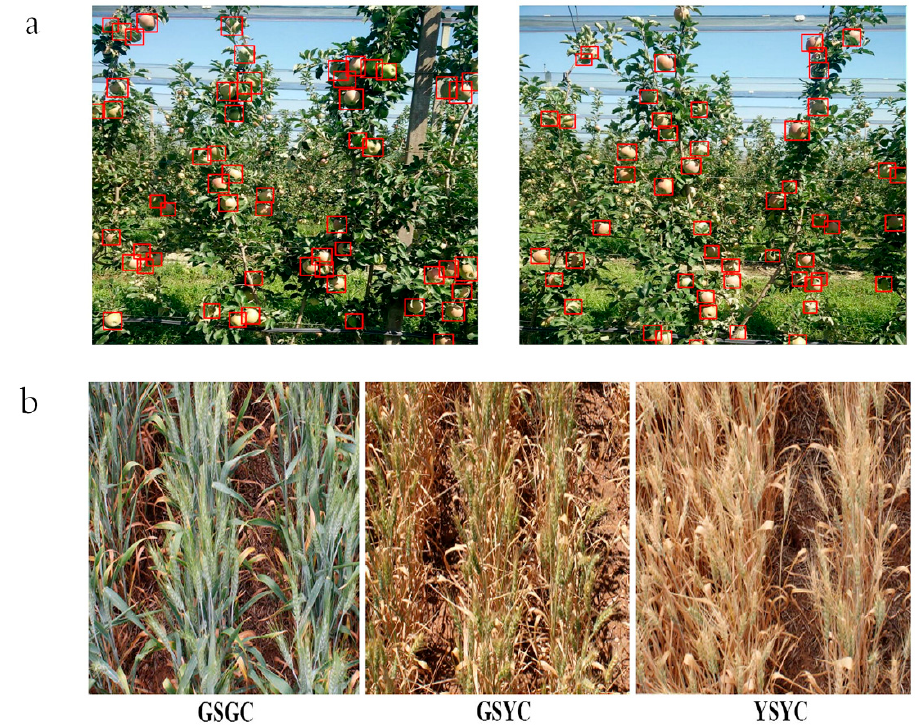
Figure 1. Dense scenes in agriculture. ( a ) Detecting fruits in an orchard. Source: [31] is licensed under https: // creativecommons.org / licenses / by / 4.0 / ; ( b ) Green Spike and Green Canopy (GSGC), Green Spike and Yellow Canopy (GSYC), Yellow Spike and Yellow Canopy (YSYC). Source: [32] is licensed under https://creativecommons.org/licenses/by/4.0/.